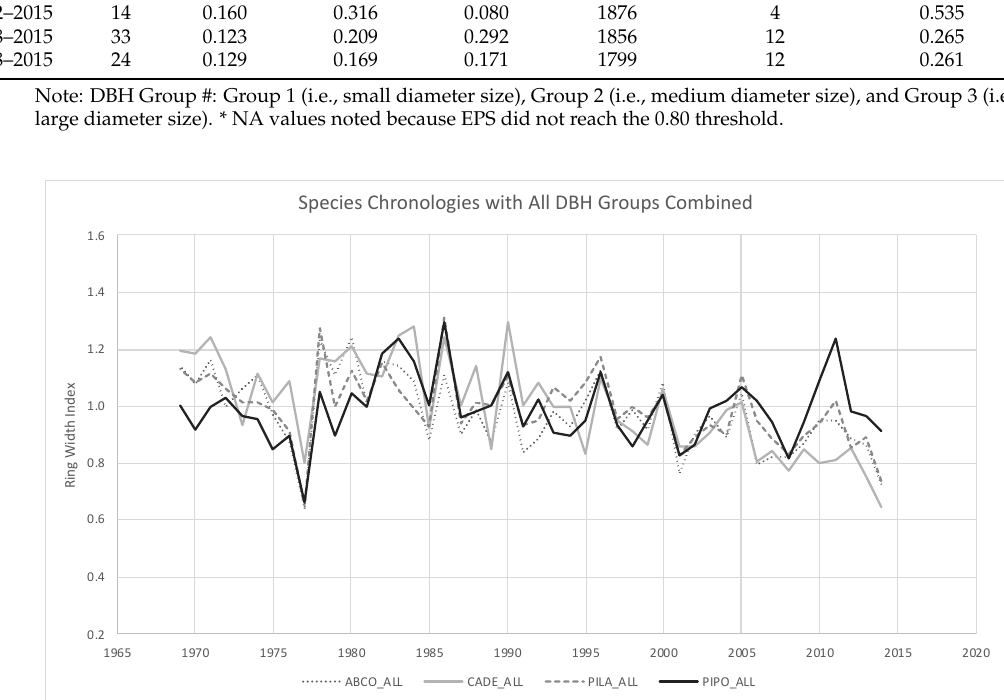
Figure 4. Species standardized chronologies with all DBH Groups combined for the time frame of the dendroclimatological analysis (1969–2014). Table 2. Statistics for the standardized tree ring chronologies for each species and DBH group.